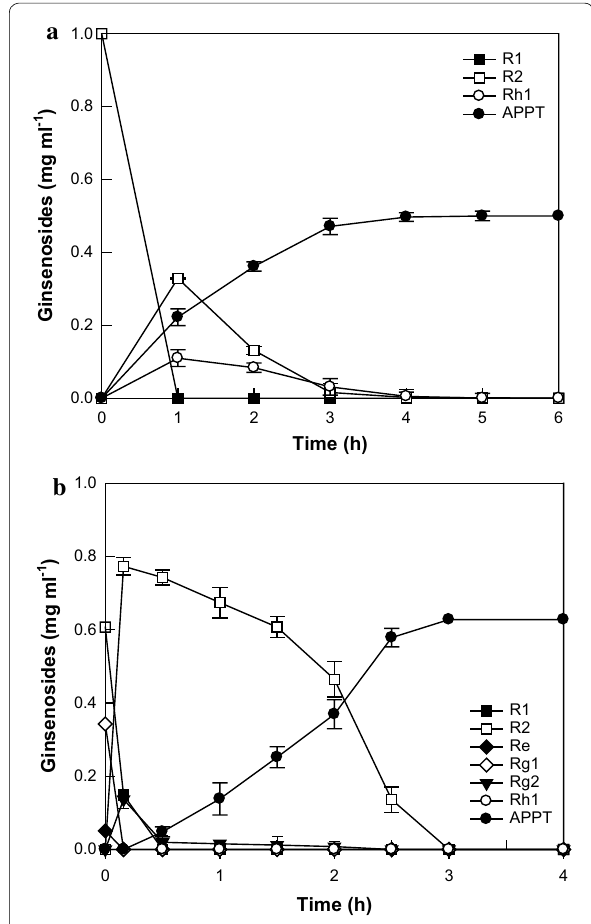
Fig. 5 Time‑course reactions for the biotransformations of PPT‑type ginsenosides to APPT by DT‑bgl combined with PF‑bgl. a Ginsenoside R1. The reactions were performed at 80 °C in 50 mM citrate/phos‑ phate buffer (pH 6.0) containing 1.0 mg ml − 1 R1, 4.0 mg ml − 1 DT‑bgl, and 5 µg ml − 1 PF‑bgl for 6 h. b PPT‑type ginsenosides in notoginseng root extract. The reactions were performed at 80 °C in 50 mM citrate/ phosphate buffer (pH 6.0) containing 1.0 mg ml − 1 total PPT‑type